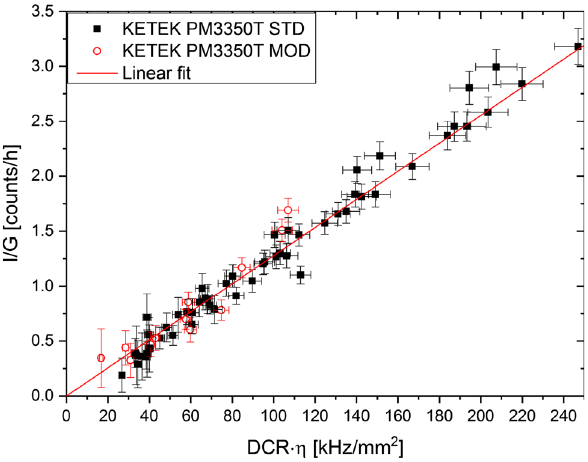
Fig. 11 Linear correlation between ( I / G ) and ( DCR · η)